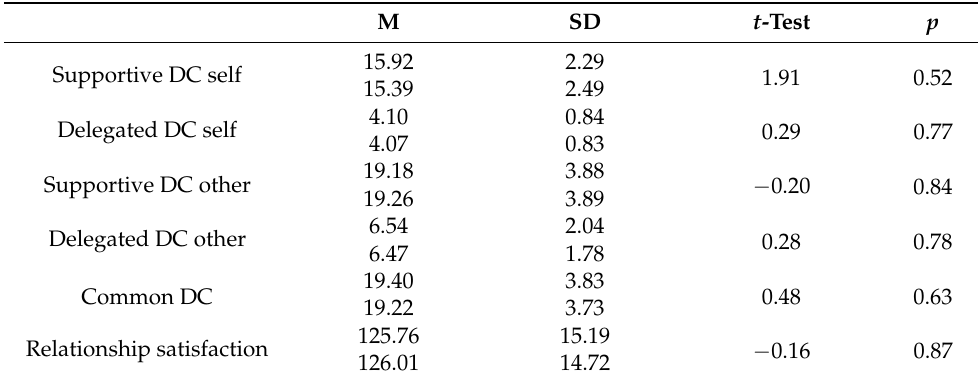
Table 1. Descriptive statistics and gender differences.